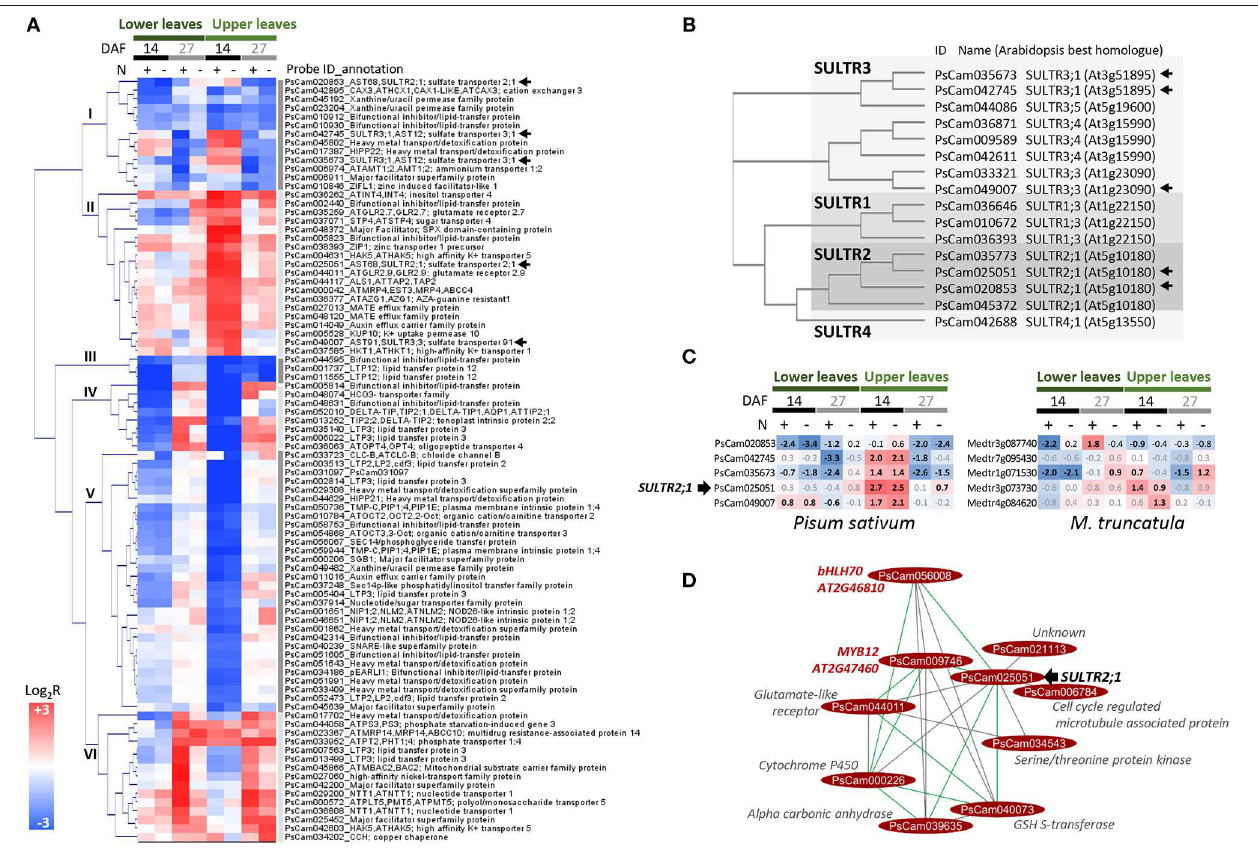
FIGURE 3 | Transporter genes differentially expressed ( ≥ 4-fold) in pea leaves between at least two stages. (A) Hierarchical clustering of expression profiles in lower and upper leaves. The color scale indicates Log 2 R for the comparisons 14 DAF vs. flowering (14), 27 DAF vs. 14 DAF (27), and in response to nitrate-deficiency (N–). Arrows indicate sulfate transporter (SULTR) genes. (B) Phylogenetic tree of SULTR sequences identified in the Pea RNAseq Atlas ( Alves-Carvalho et al., 2015). (C) Expression (array data) of pea SULTR genes marked by an arrow in (A,B) and expression profile of the Medicago truncatula (M. truncatula) orthologs (In bold, Bonferroni-corrected P -value < 0.05). (D) Genes connected to PsCam025051/SULTR2;1 in